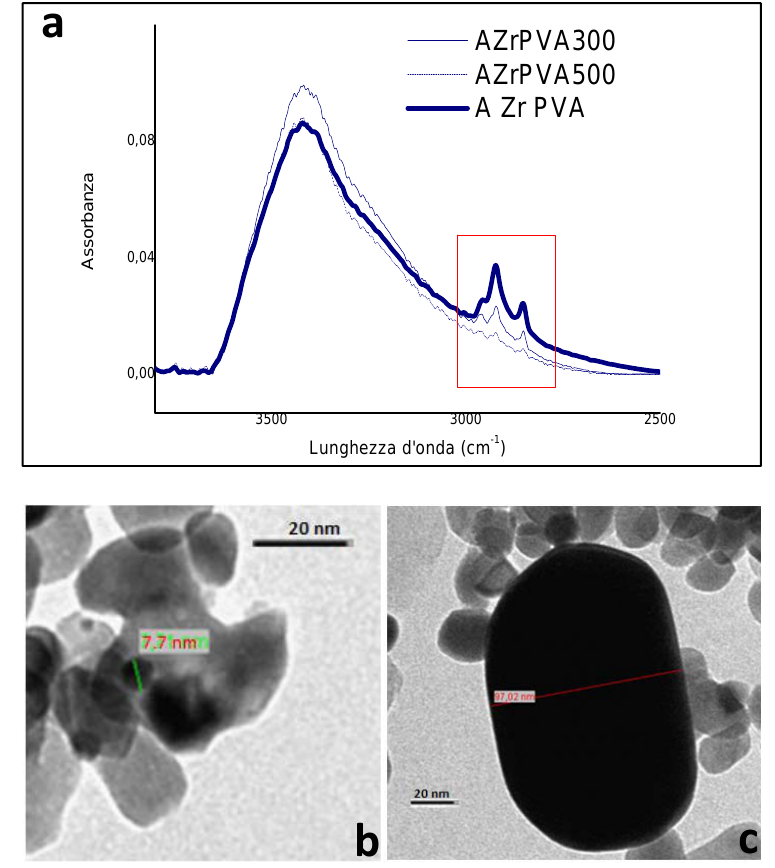
Figure 9. FT-IR spectra of AZrPVA (thick), AZrPVA300 (thin); AZrPVA500 (dashed) (section a ). TEM images of the AZrPVA300 (section b ) and AZrPVA500 samples (section c ).